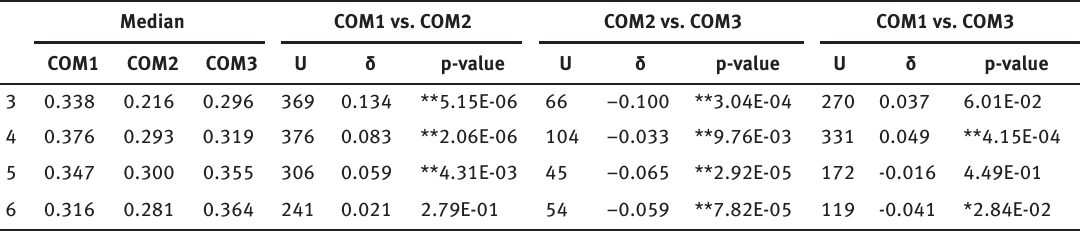
Table 5: Results of the MWW test between each pair of variants of the model. Calculations performed in R using the ‘wilcox. test’ function. We report median similarities for each variant of the model, the value of the U statistic, the location shift δ between the two distributions, and p-values. Significant differences are marked in the p-values, with ** for a 99% confidence level and * for